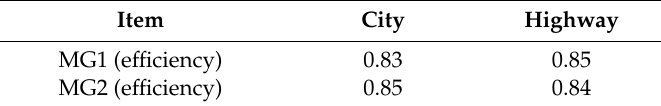
Table 4. Motor / generator e ffi ciency in RB.